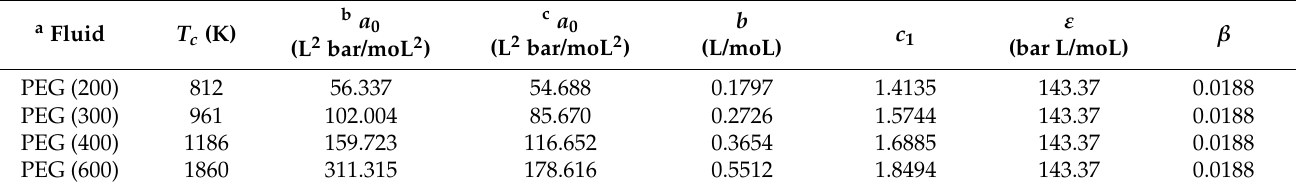
Figure 1. Correlations of pure fluid parameters for glycols and extension to higher molecular weights. Table 2. Pure fluid parameters for polyethylene glycols; the average molecular weight is shown in